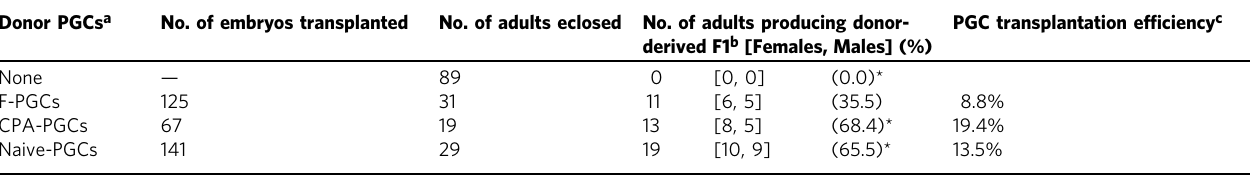
Table 1 Production of offspring derived from donor PGCs. Donor PGCs a No. of embryos